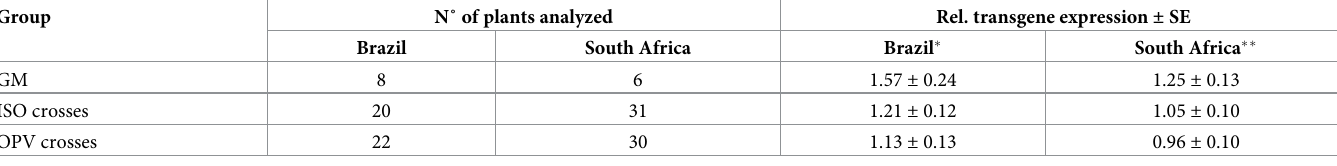
� F = 2.133; df = 2; P = 0.131. �� F = 0.788; df = 2; P =